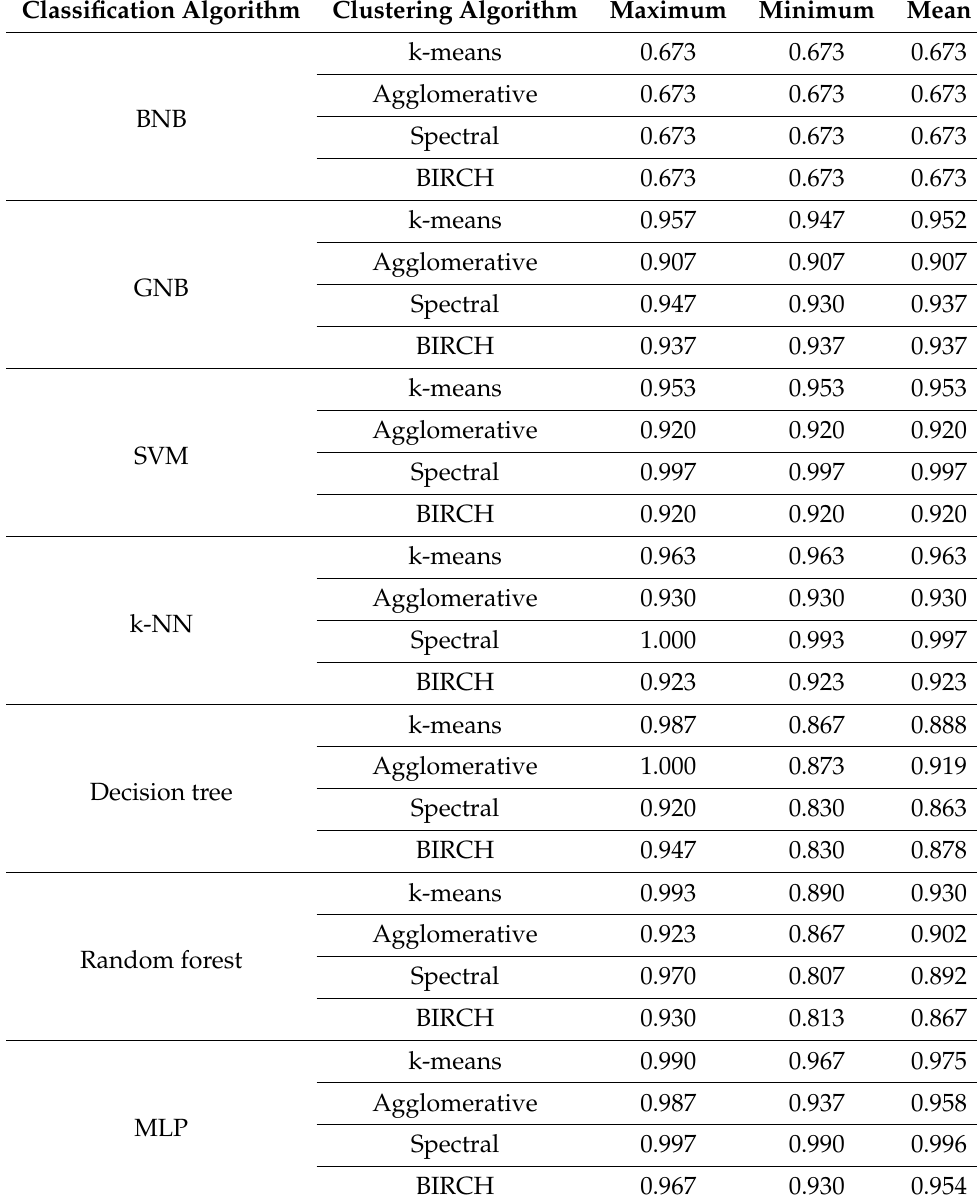
Table 1. Testing accuracies of different combinations of classification and clustering algorithms in MMD-SSL